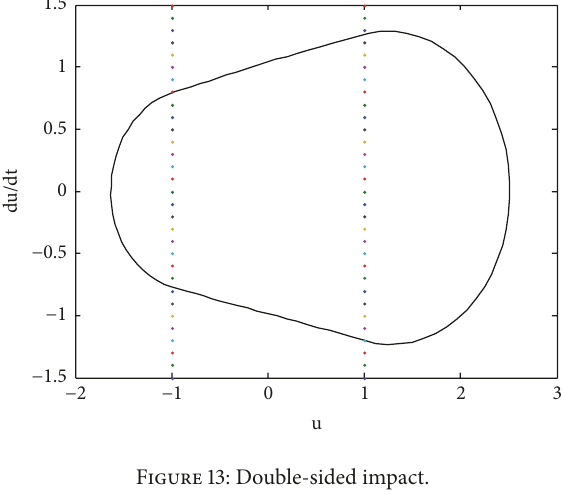
Figure 12: The mapping structures.